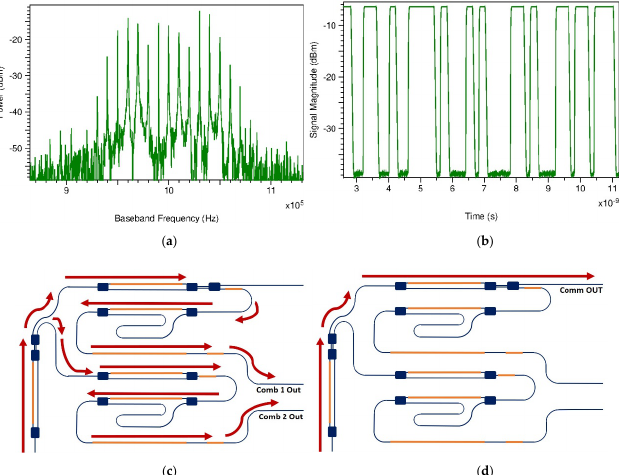
Figure 9. ( a ) Dual-Comb signal after photodetection. Comb centered on IF frequency. ( b ) Optical OOK signal when modulating MZM by PRBS. ( c ) Path followed by the light to obtain the Dual-Comb signal on ( a ). ( d ) Path followed by the light to obtain the OOK signal on ( b